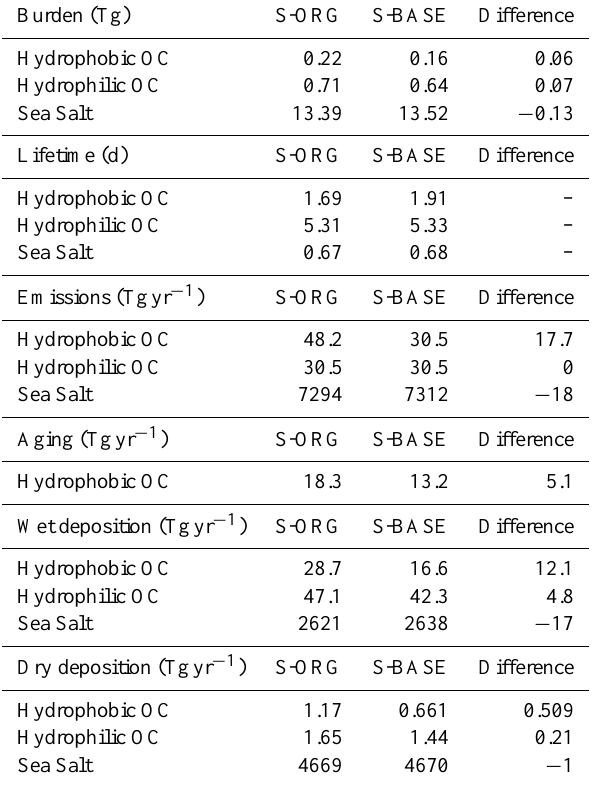
Table 3. Global aerosol budgets for marine organic aerosol simula-